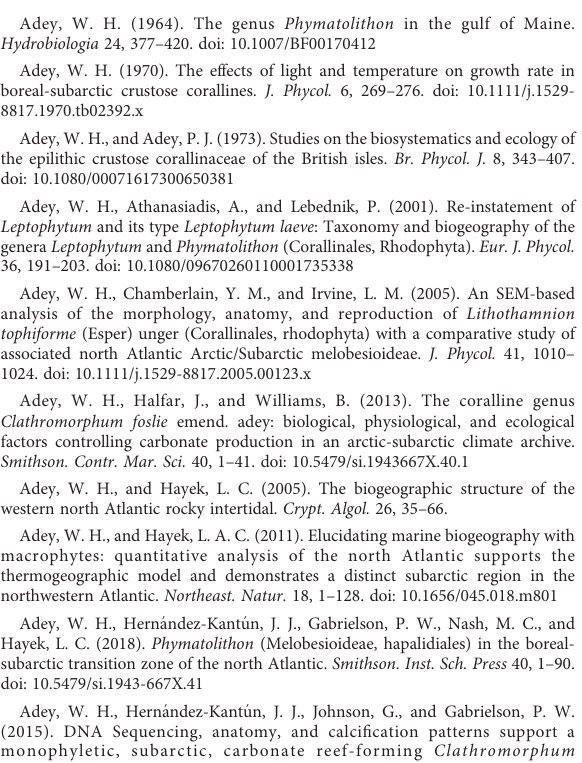
SUPPLEMENTARY TABLE 1 List of specimens and their information used in the molecular analyses. Type/topotype material are in bold; Taxa are listed in alphabetical order; ‒ indicates no sequence available; Genera in single quotes represent genus names of uncertain status. SUPPLEMENTARY TABLE 2 Sequence divergence values of psbA sequences. SUPPLEMENTARY TABLE 3 Sequence divergence values of rbcL sequences. SUPPLEMENTARY TABLE 4 Comparison table of vegetative morphological characters of P. abuqirensis and closely related